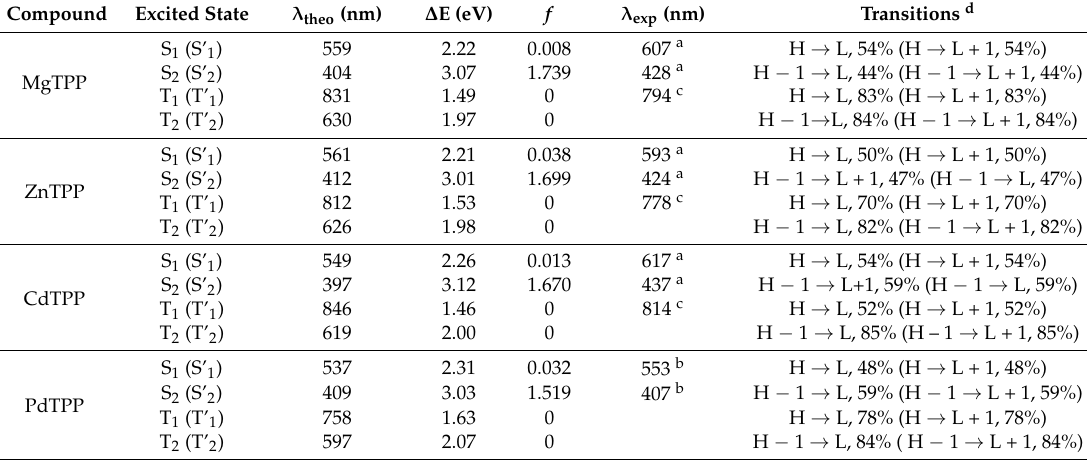
Table 1. Main vertical excitation energies ( ∆ E), absorption wavelengths ( λ ) Oscillator Strengths ( f ) and Transitions (Molecular Orbital contribution in %) for the studied compounds in benzene solvent, computed at the M06/6 − 31 + G * level of